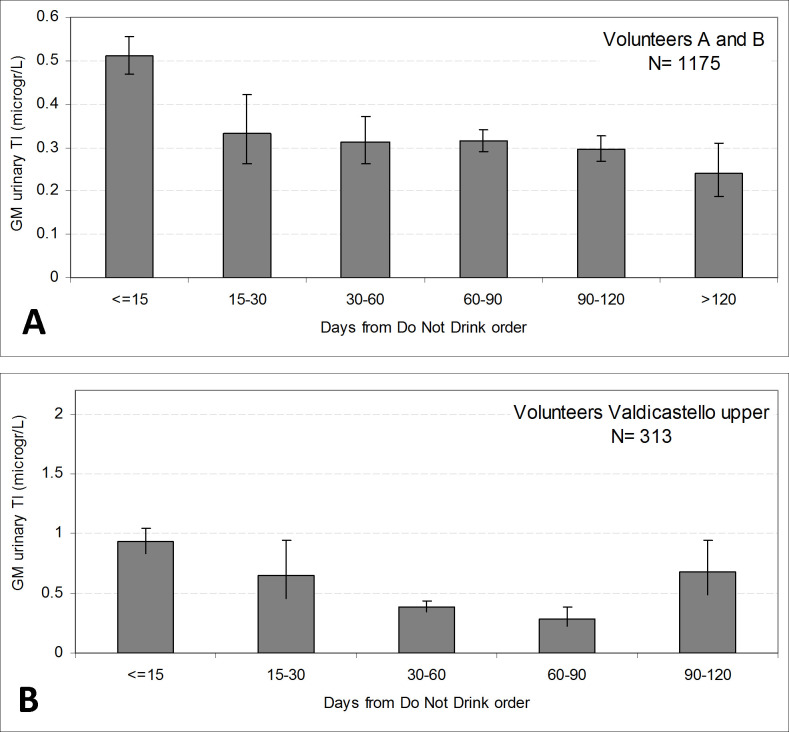
Temporal pattern of Tl urinary excretion: Geometric means (95% confidence intervals) by days from the Do Not Drink order.(A): groups of volunteers A and B. (B): Valdicastello upper volunteers.